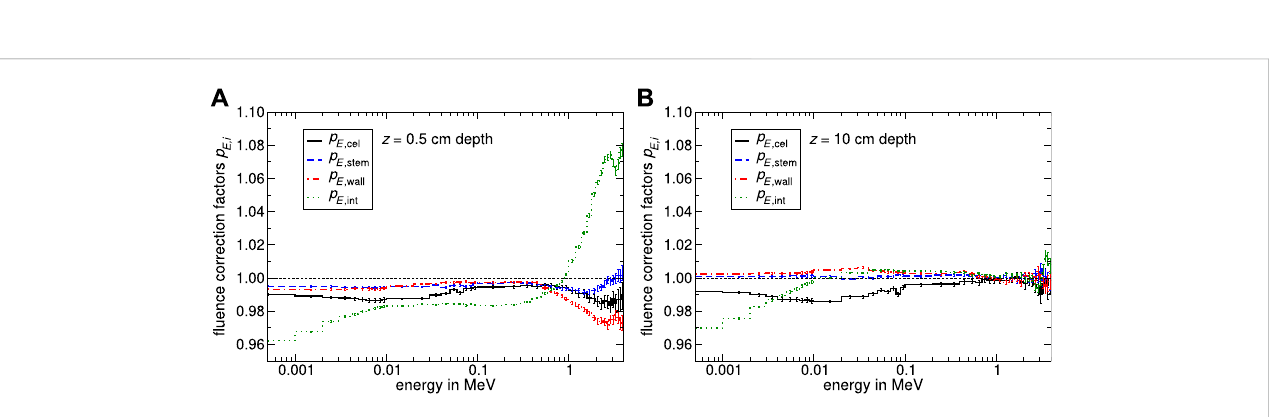
FIGURE 10 Monte Carlo calculated speci fi c fl uence correction factors p E , i for different constructive details from the SNC125c ™ as a function of energy. Panel (A) shows the spectral speci fi c fl uence correction factors p E , i , whereby the shifted EPOM was positioned at 0.5 cm depth. In sub fi gure (B) p E , i was calculated at 10 cm depth. The uncertainty varies depending on energy in a range of 0.06% –